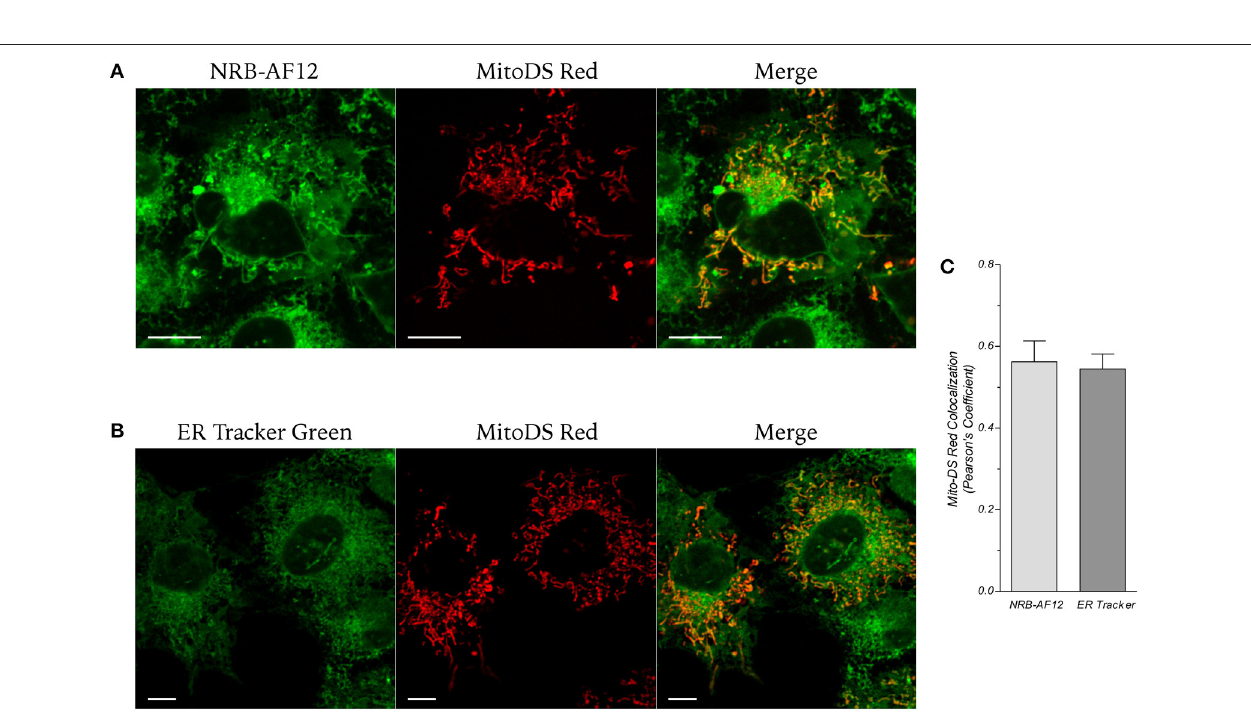
FIGURE 6 | Live cell imaging of liver myofibroblasts transfected with the mitochondrial marker Mito-Ds red and then stained using (A) NRB-AF12 or (B) ER-Tr green. Magnification 60x; scale bar 10 µ m. (C) Co-localization of NRB-AF12 and ER-Tr within mitochondria is reported as Pearson’s coefficient ( n ≥ 10).